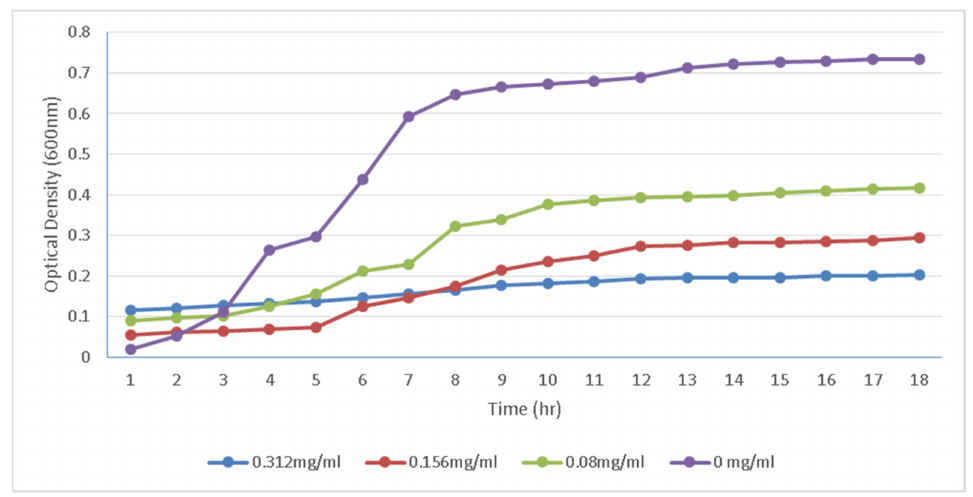
Figure 3. Time-kill plot for MRSA in the presence of 11a .